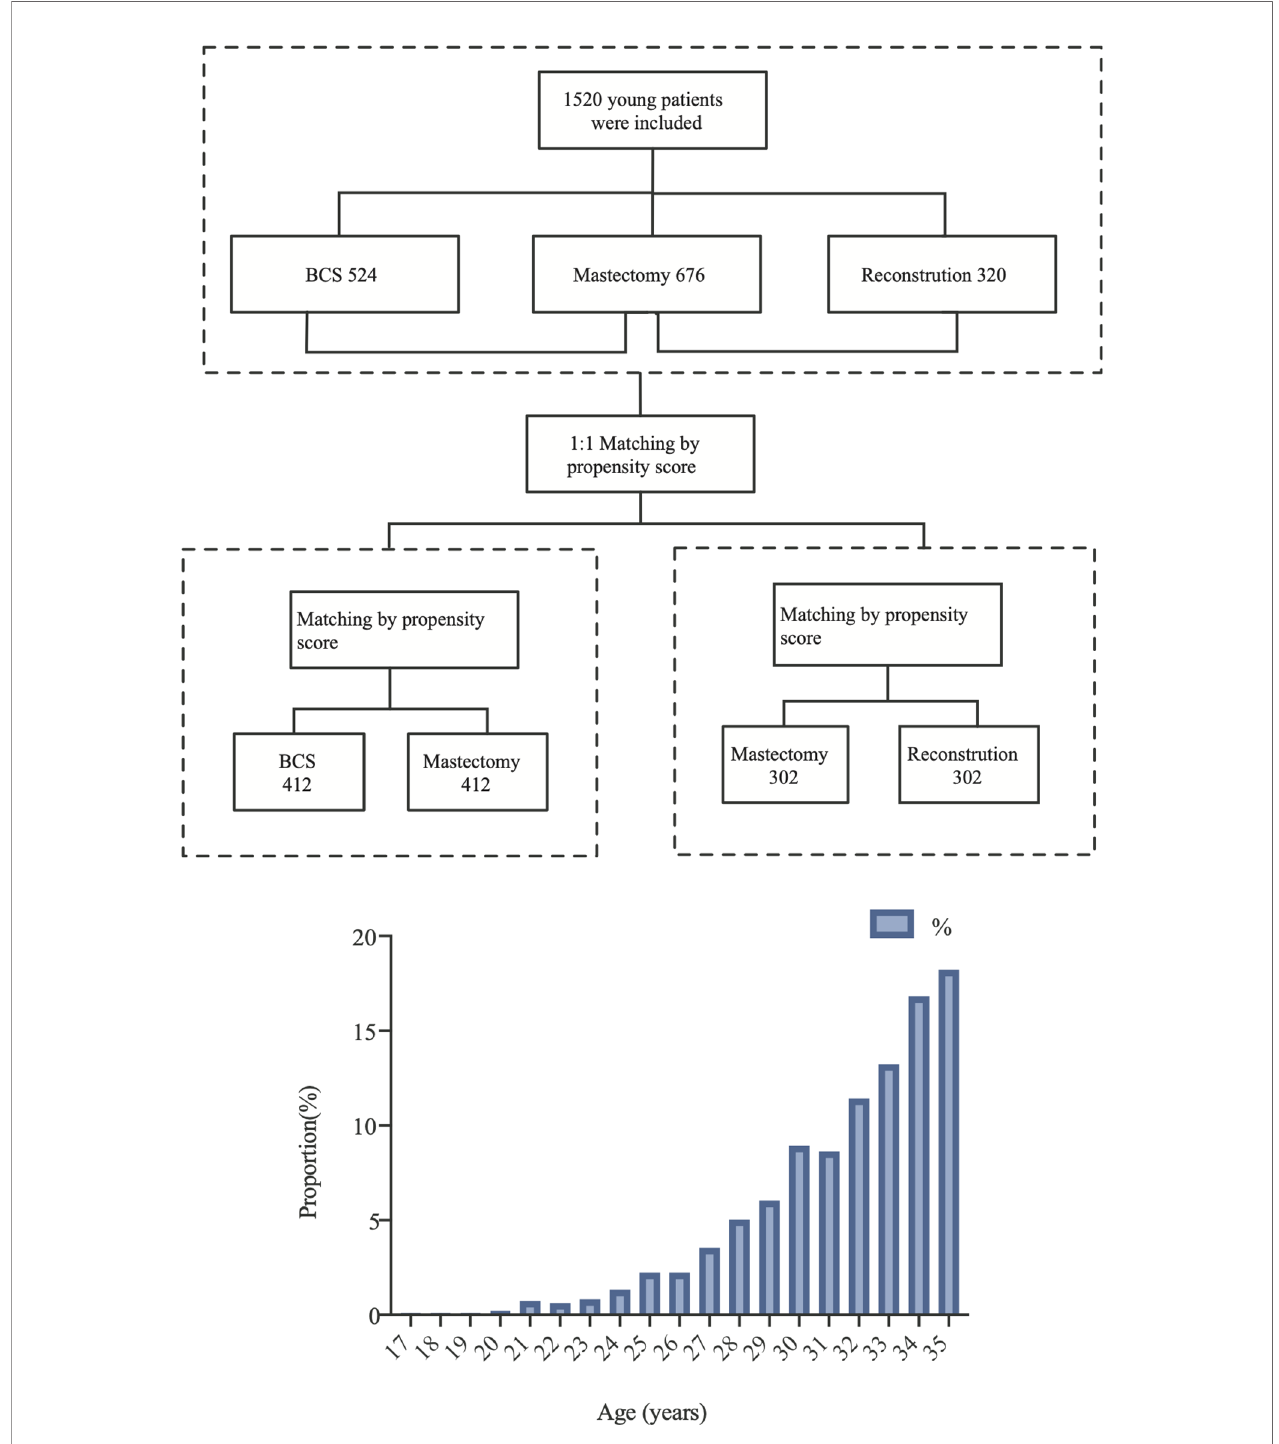
FIGURE 1 | Flowchart and age composition ratio of included